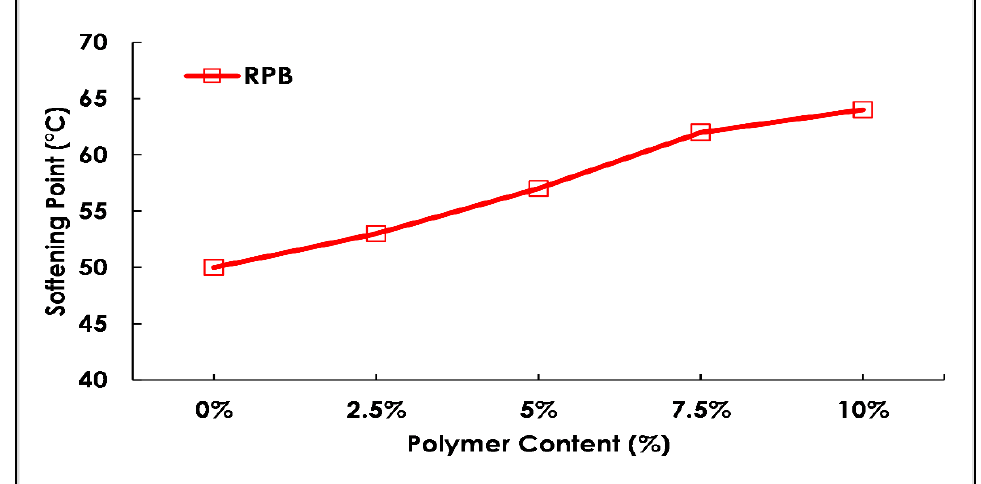
Figure 9. Softening test results with varying polymer content (%).